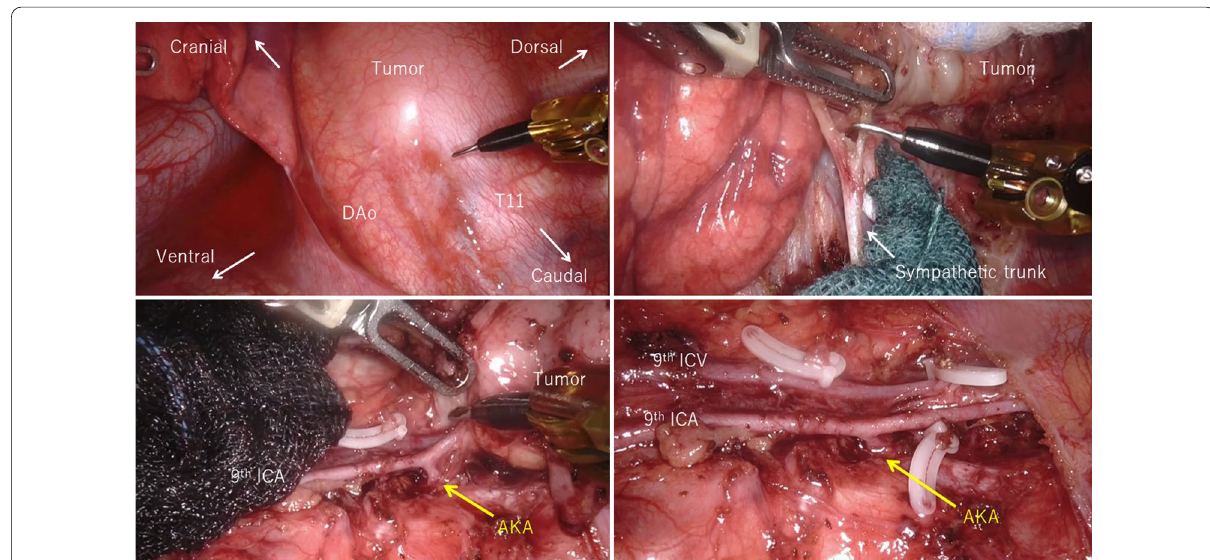
Fig. 4 Well-circumscribed large paravertebral tumor, which originated from the sympathetic trunk, was identified (left upper and right upper). The nerve of origin was divided from the sympathetic trunk (right upper). Tumor-feeding arteries arose from the 9th intercostal artery (ICA) were dissected with preserving the artery of Adamkiewicz (AKA) (left lower). Complete tumor resection was achieved by robot-assisted thoracic surgery (RATS) with preserving the AKA as well as the 9th ICA and intercostal vein (ICV) (right lower). T11, 11th thoracic vertebra; AKA artery of Adamkiewicz, ICA intercostal artery, ICV intercostal